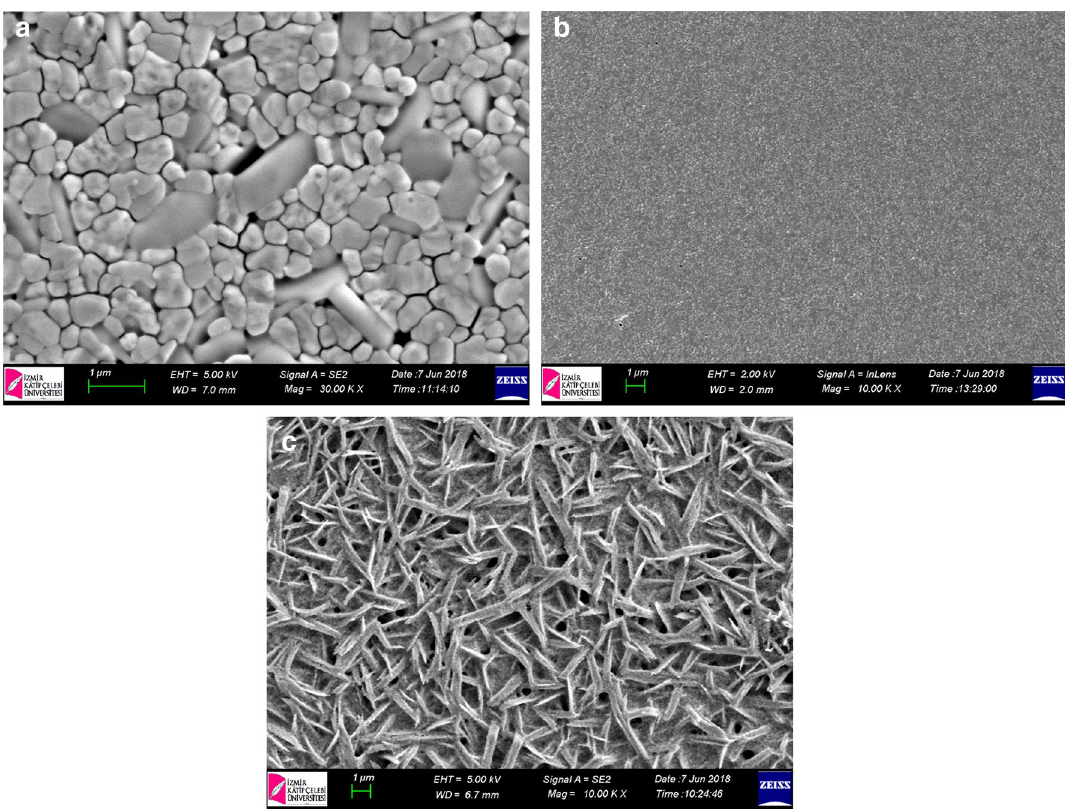
Figure 2. ( a – c ) SEM images of perovskite layer on sepiolite scaffold prepared from ( a ) ACN ( b ) GBL and ( c ) DMF:DMSO